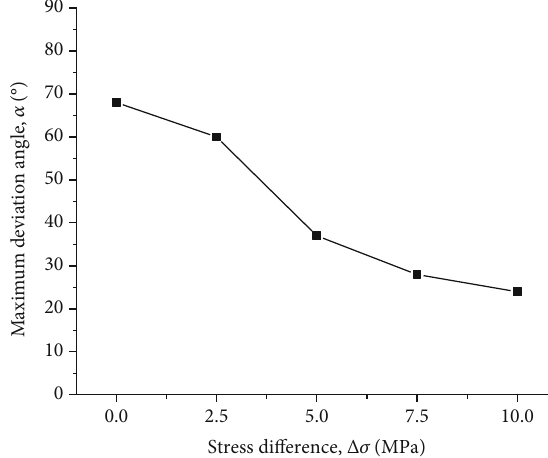
Figure 10: Variation of the maximum deviation angle ( α ) for varying stress di ff